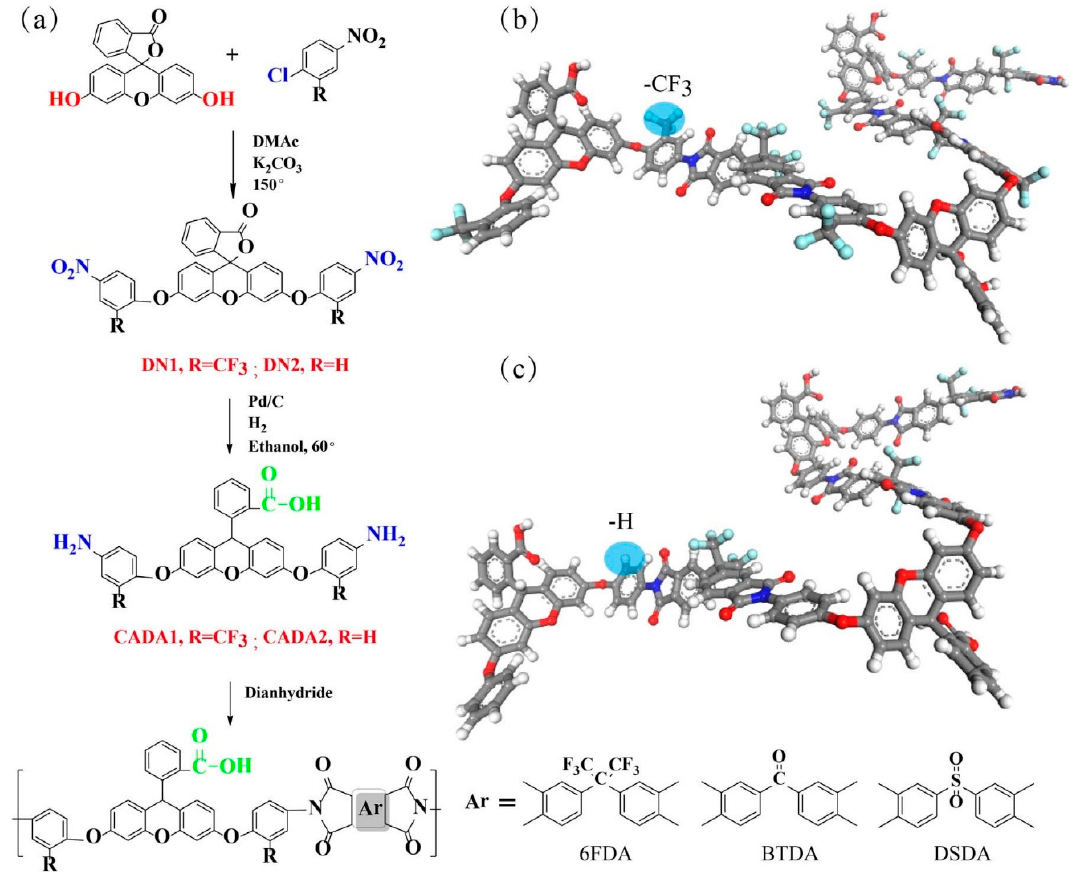
Figure 6. ( a ) Synthesis routes of dinitro monomers, diamines as well as and 6FDA-, BTDA-, and DSDA-based carboxylic acid-containing polyimides, ( b ) and ( c ) show the energy-minimized chain conformations of 6FDA-CADA1 and 6FDA-CADA2 polymers, respectively (using Material Studio 7.0) [58].